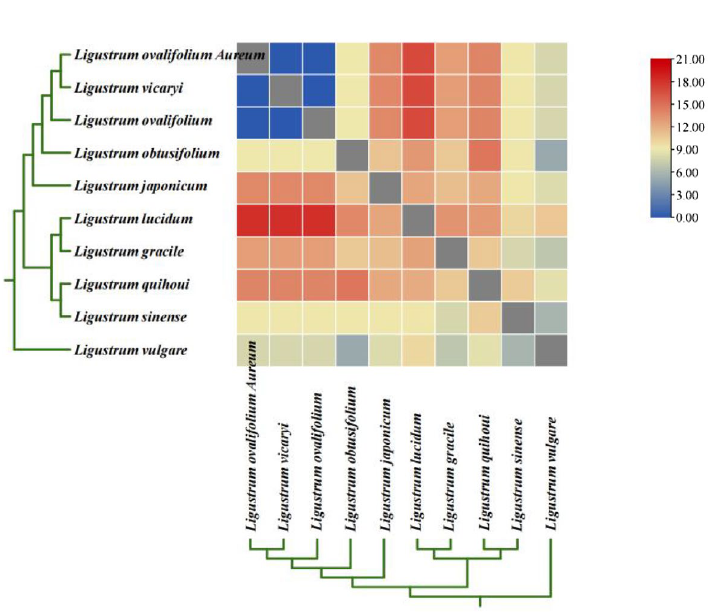
Figure 8. Pairwise Ka/Ks ratios ten Ligustrum species. This heatmap shows pairwise Ka/Ks ratios between every sequence in the multigene nucleotide